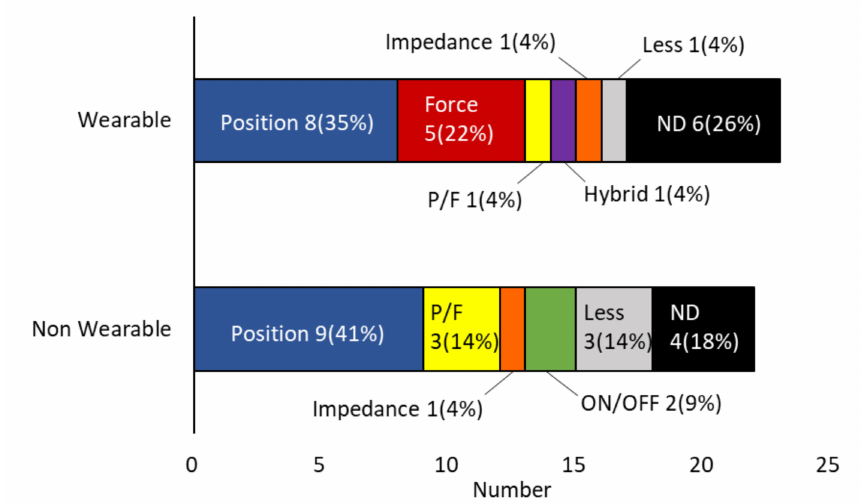
Figure 6. Summary of control strategy